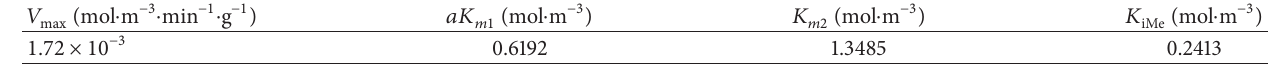
Table 2: Kinetic coefficients of Limczyme.